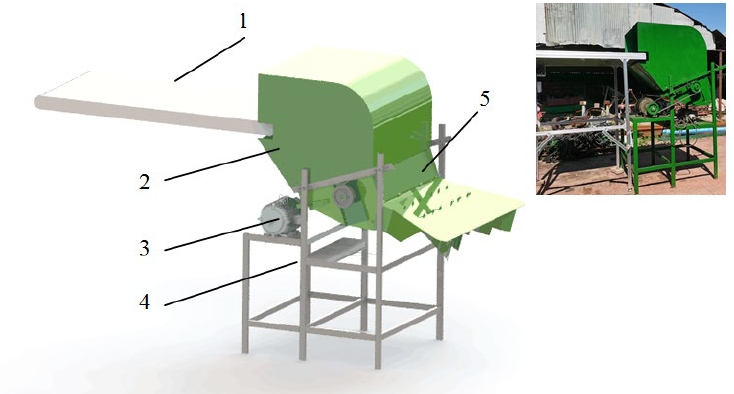
Figure 11. Structure diagram of the test bench. Note: (1) straw conveyor belt; (2) safety box; (3) motor; (4) support stand; (5) SCTD.